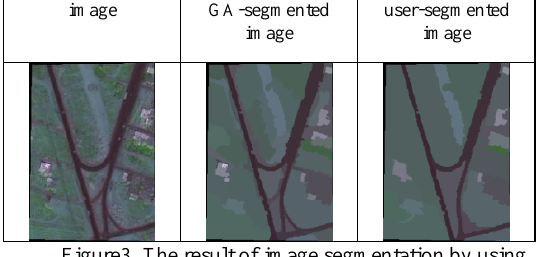
Figure3. The result of image segmentation by using parameters optimized by GA and the user